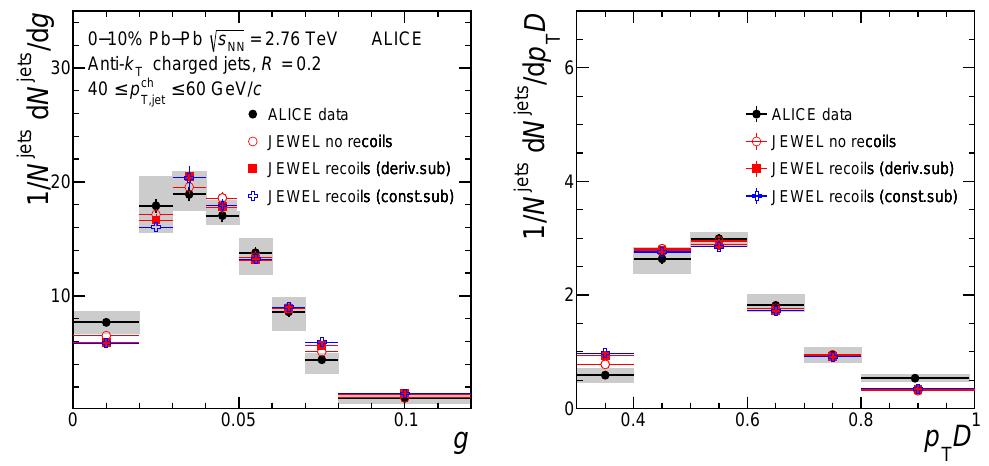
Figure 2. Jet shape distributions g ( left ) and p T D ( right ) in 0–10% central Pb–Pb collisions √ s NN = 2.76 TeV for R = 0.2 in range of jet p ch at without recoils with different subtraction methods. The colored boxes represent the experimental uncertainty on the jet shapes [13].